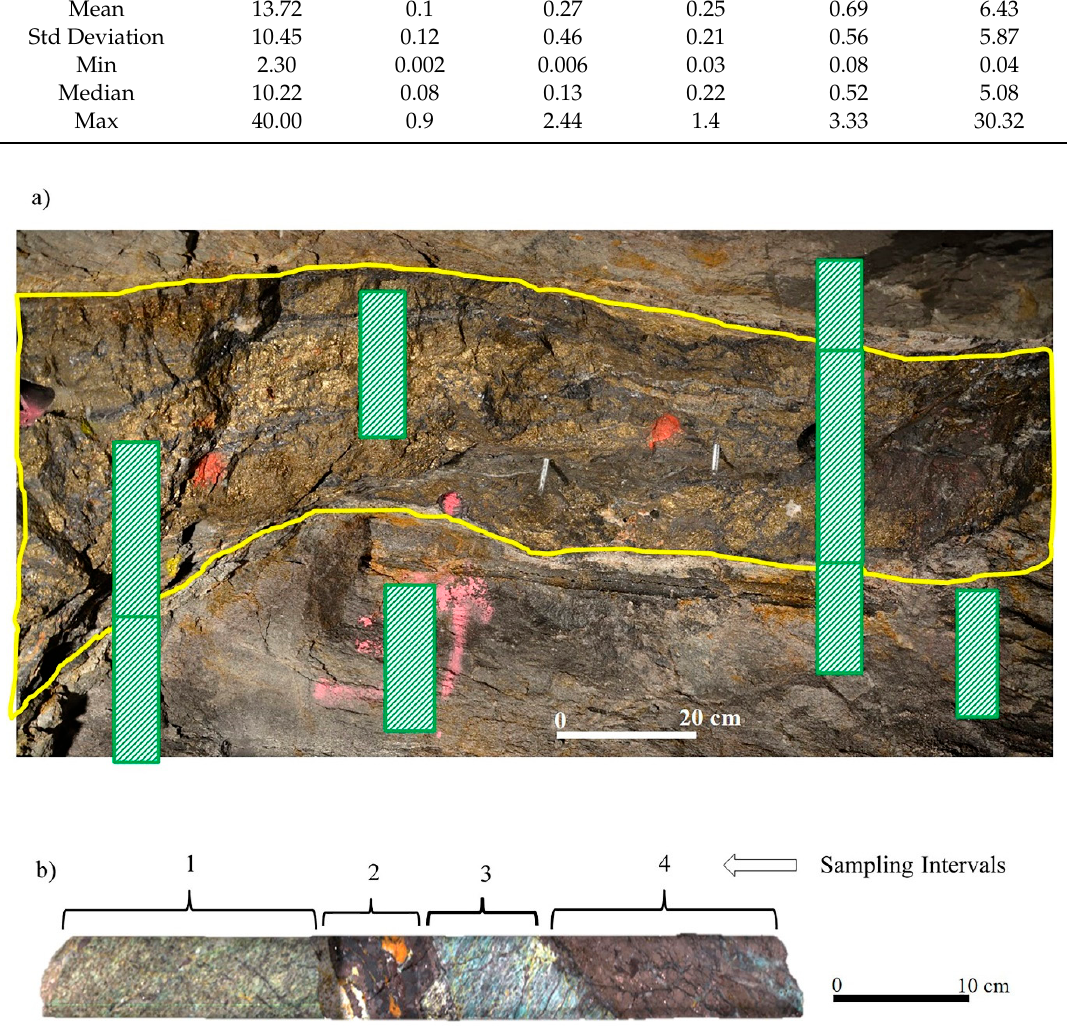
Figure 3. Photographs showing some of the sampling locations: ( a ) channel cuts at the mine face (the green boxes). The yellow line shows the ore zone boundary; and ( b ) a drill core showing the different lithotypes that were sampled separately.